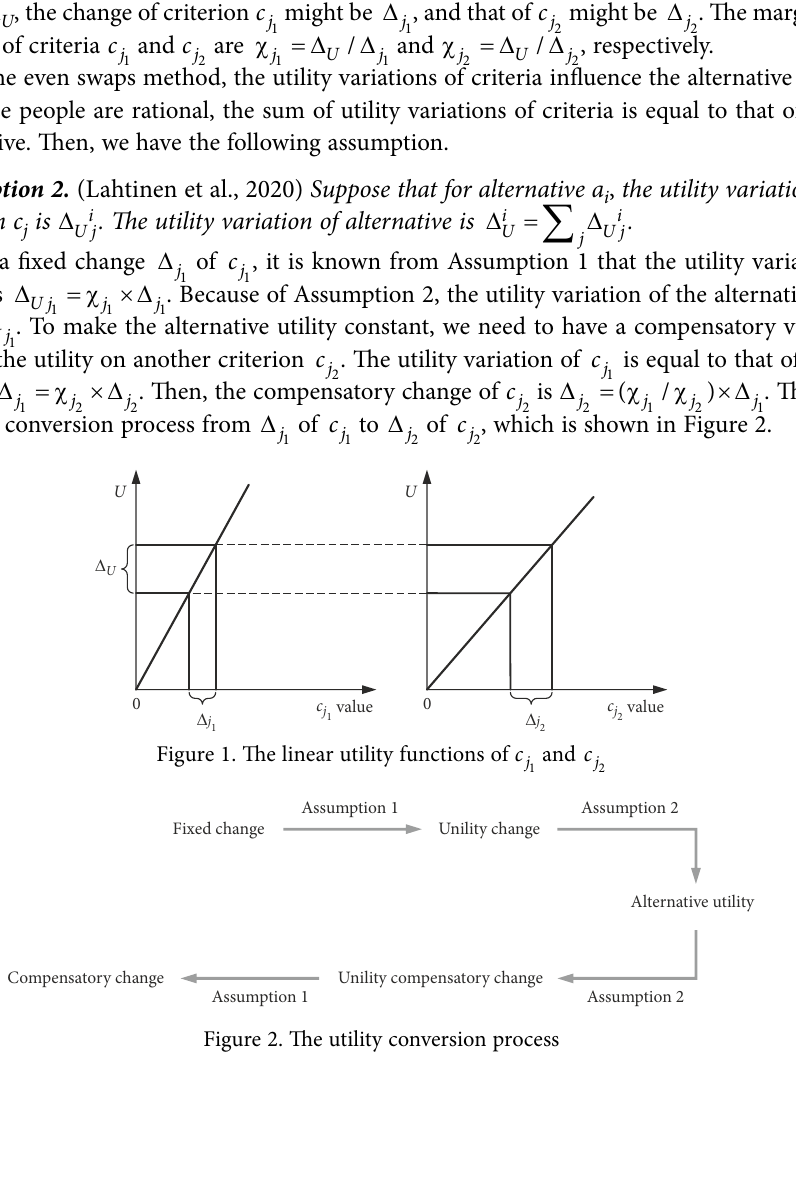
c . In Figure 2, for a variation of 2 j